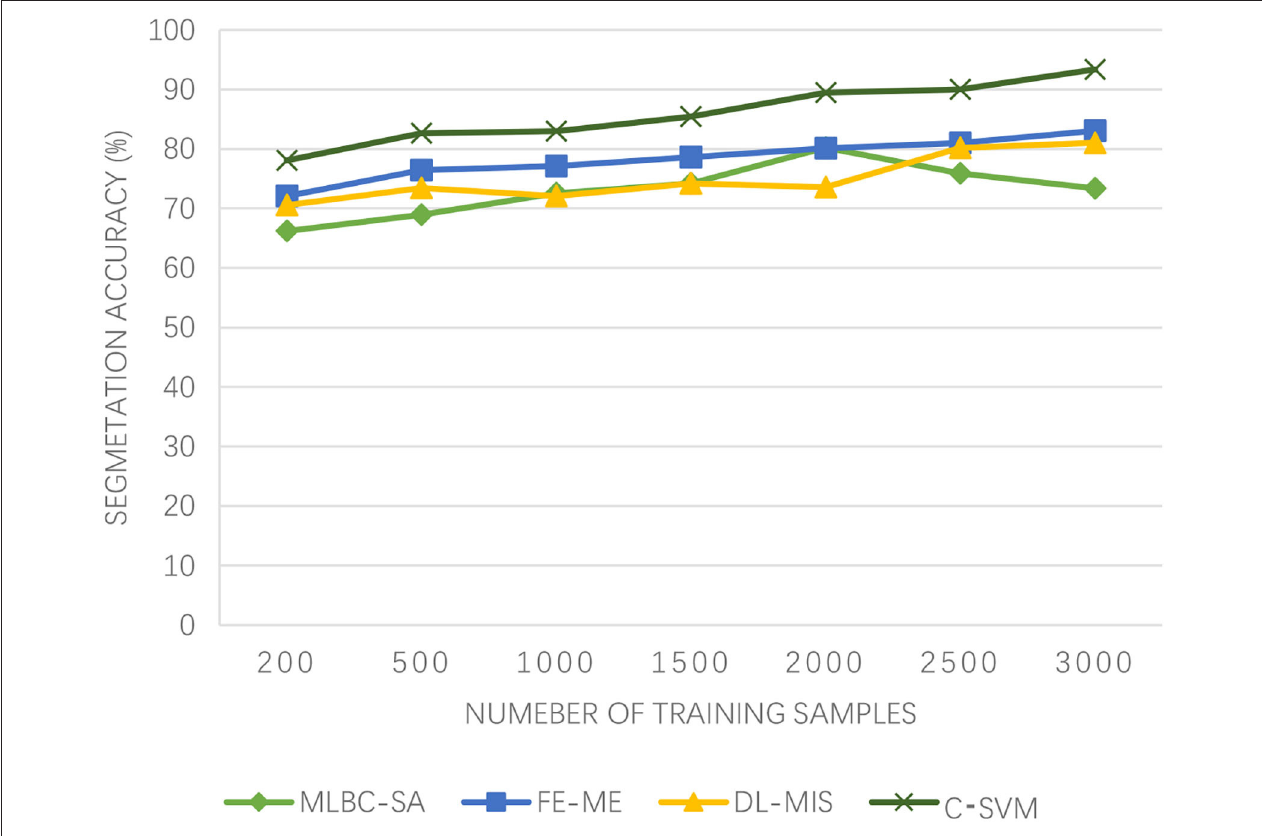
FIGURE 3 | Experimental results of segmentation